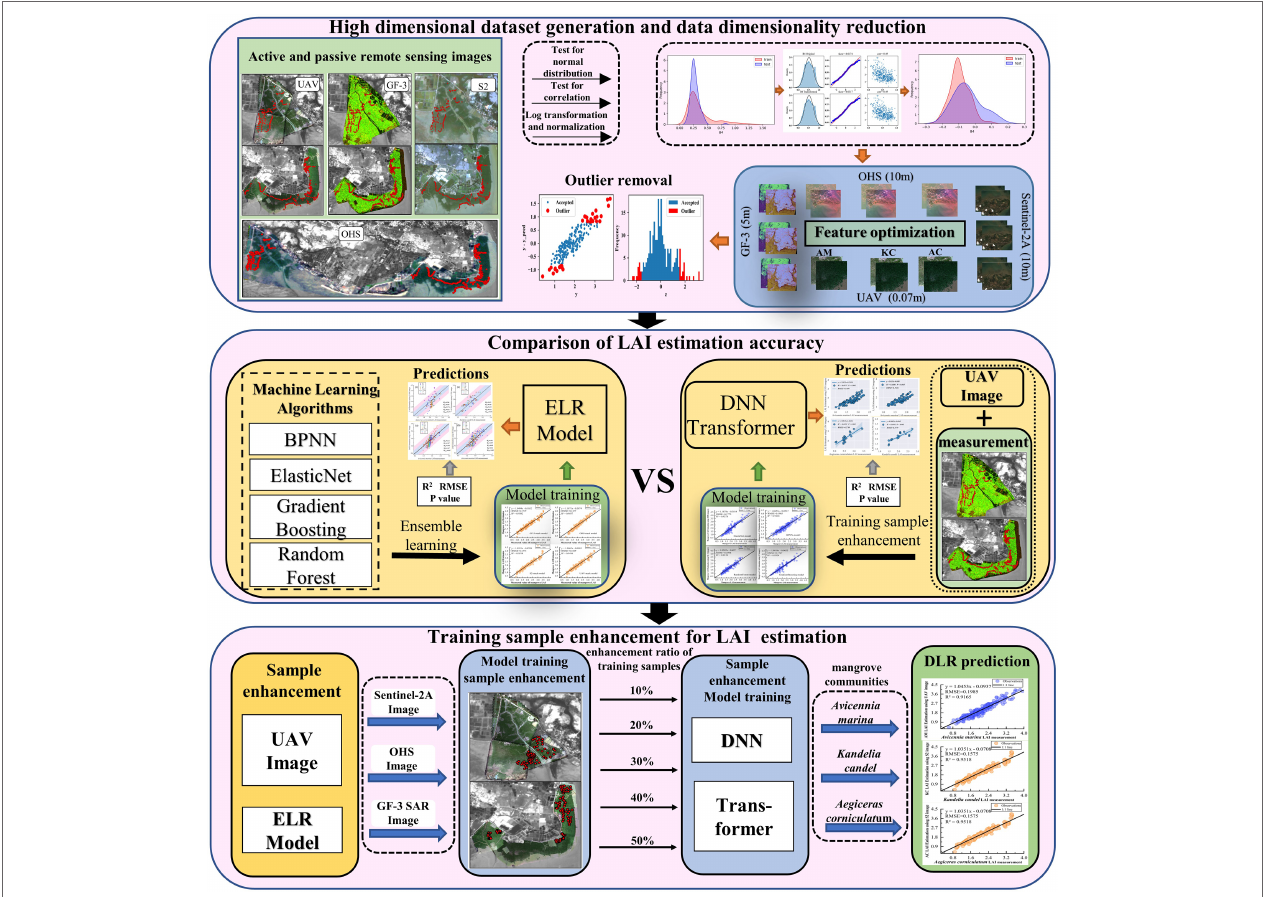
FIGURE 3 | Experimental flow chart.